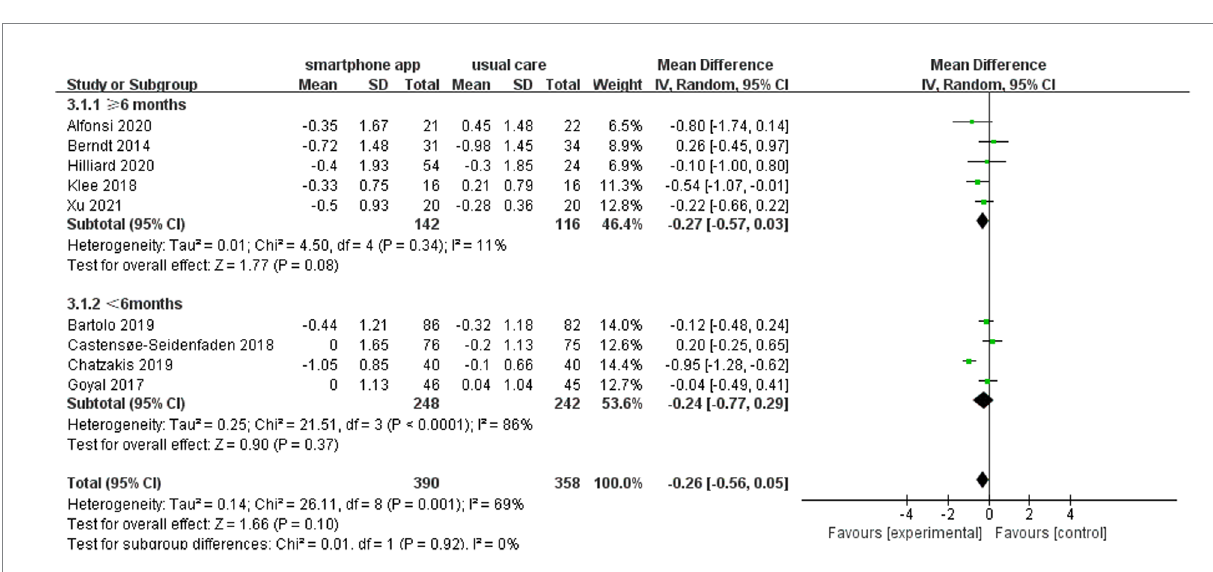
FIGURE 5 Forest plot of smartphone app interventions with different study durations and changes in